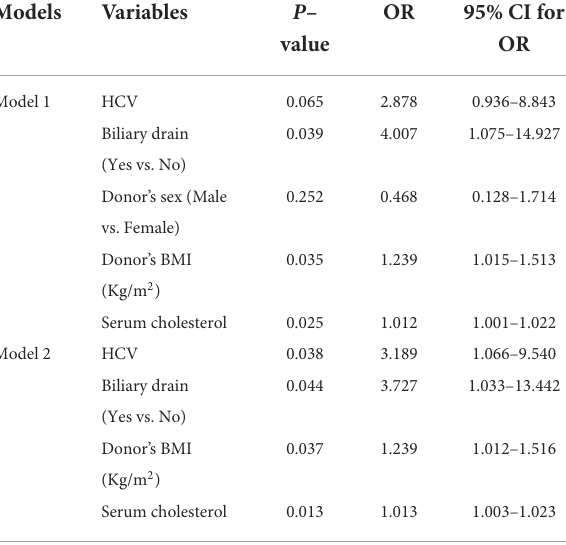
TABLE 7 Univariate logistic regression analysis for determining potential risk factors of developing biliary stones post–LDLT (total n = 83).